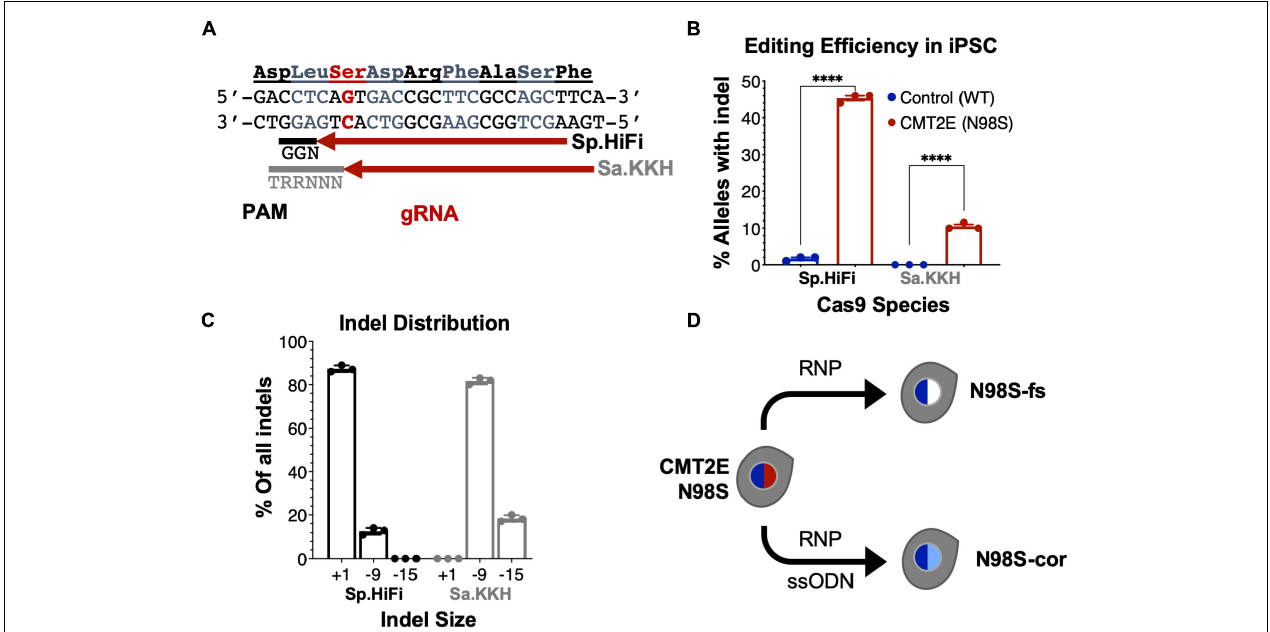
FIGURE 3 | Allele-specific editing of NEFL N98S mutation in iPSCs. (A) NEFL target sequence with N98S mutation in red and gRNAs for Sp.HiFi and Sa.KKH Cas9 targeting the antisense strand. The canonical PAM recognition sequences for Sp.HiFi and Sa.KKH are shown in black and gray, respectively. (B) Efficiency and specificity of indel generation in control and CMT2E patient lines after transfection with Cas9/gRNA ribonucleoprotein (RNP), measured by ICE analysis, **** p < 0.0001 by t -test. (C) Comparison of indel sizes generated in CMT2E patient line by Cas9 enzyme. (D) Schematic of the derivation of clonal edited iPSC lines from the CMT2E N98S patient line. Transfection of N98S iPSC with Sp.HiFi RNP produced N98S-fs (frameshift inactivating the mutant allele). Transfection of N98S iPSC with Sp.HiFi RNP plus single-strand oligonucleotide donor (ssODN) produced N98S-cor (precise correction of the mutation). Colored nuclei indicate NEFL genotype: dark blue = wild type, red = N98S mutant, white = frameshift (knockout), light blue = correction of N98S to wild